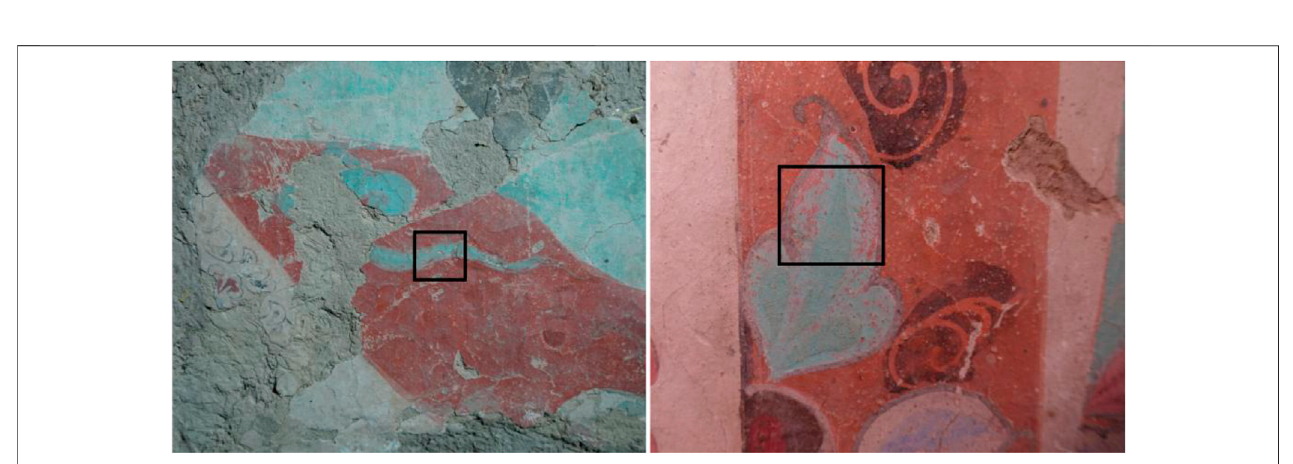
FIGURE 9 | Photo of overlapped painted layer in